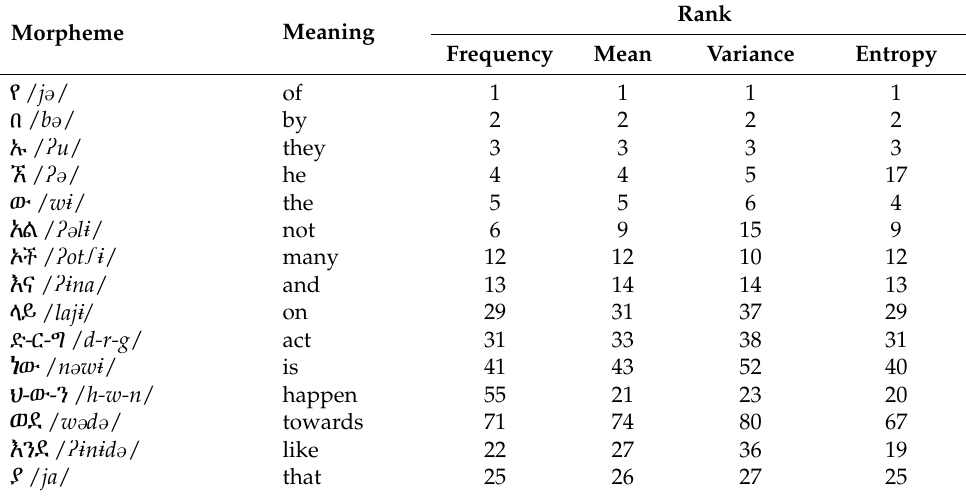
Table 4. Sample bound and free morphemes with highest statistical values.